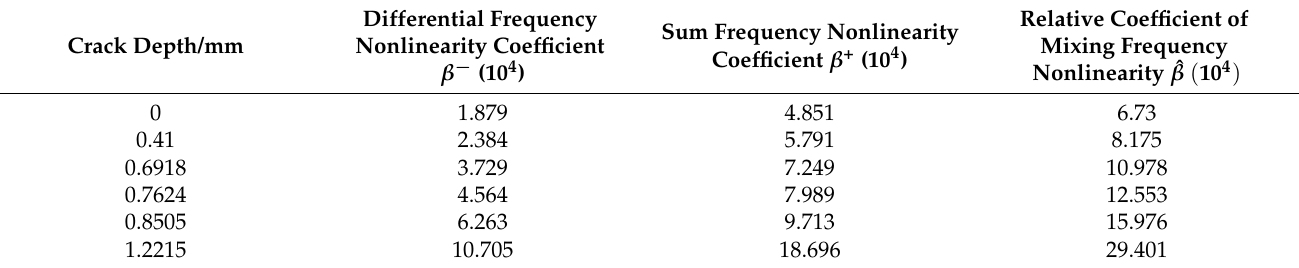
Figure 12. ( a ) Simulated signal ( b ) spectrum. Table 2. Nonlinear coefficients at different crack